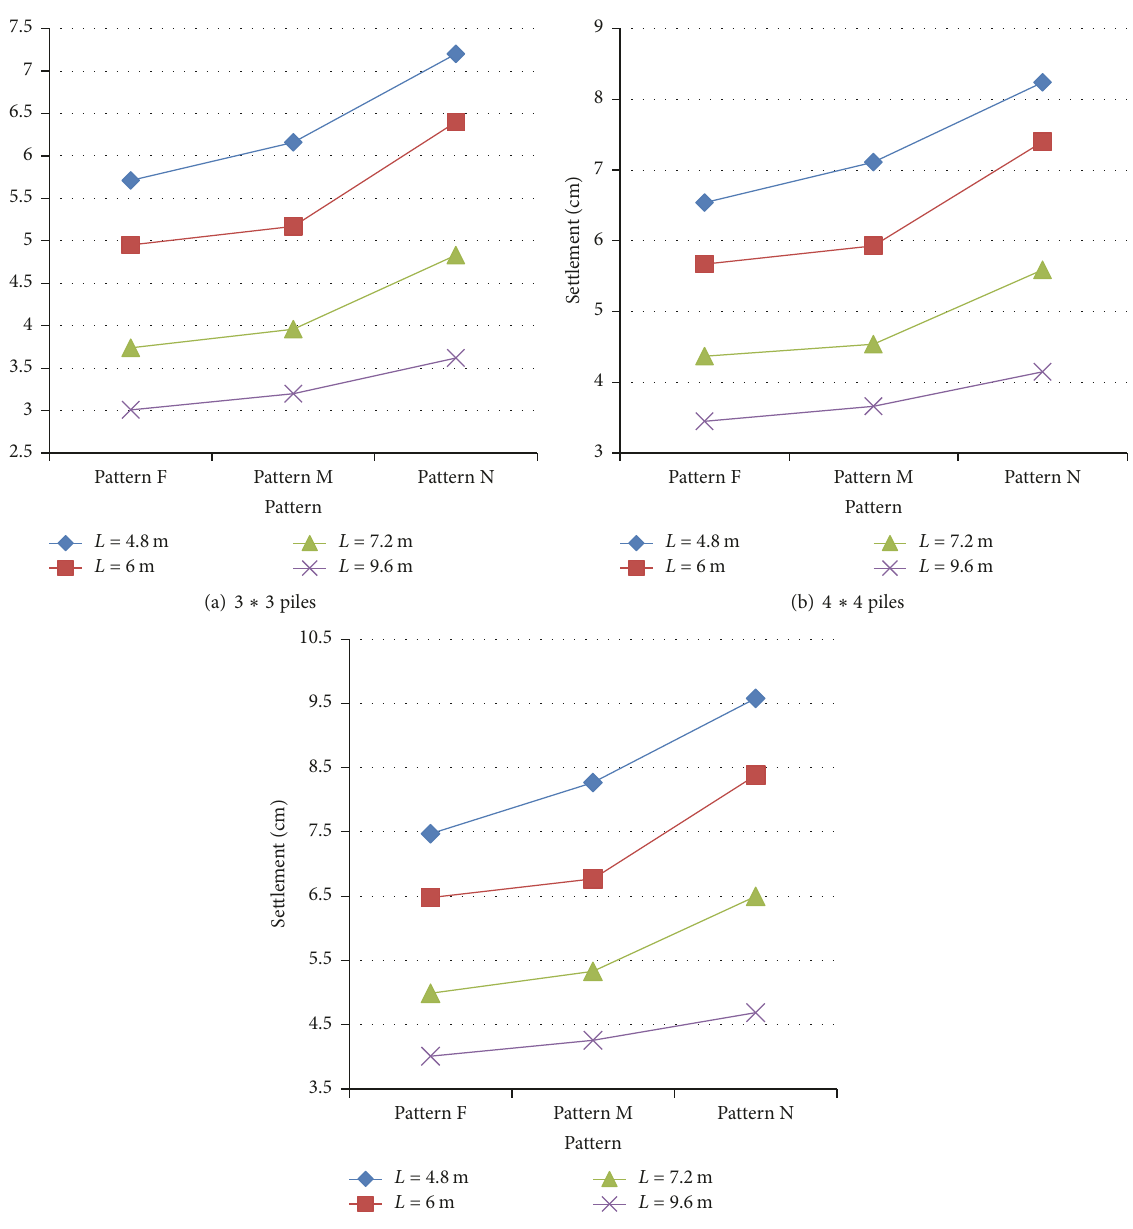
transfer functions in the prediction of coupled static-dynamic CPRF’s settlements, the mentioned transfer functions were applied and TANSIG function showing the best performance was selected for the modeling purposes. Figure 16 shows the TANSIG transfer function. Also, (8) shows the formula used to calculate TANSIG function